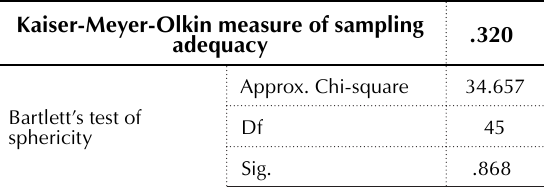
Table 20. KMO and Bartlett’s test